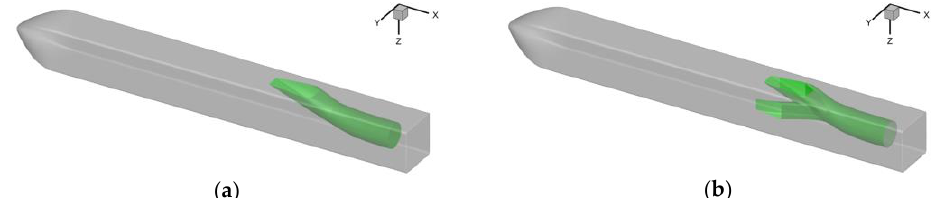
Figure 3. Two configurations of inlet and missile body.((a) Conventional inlet configuration ,(b) Distributed inlet configuration)